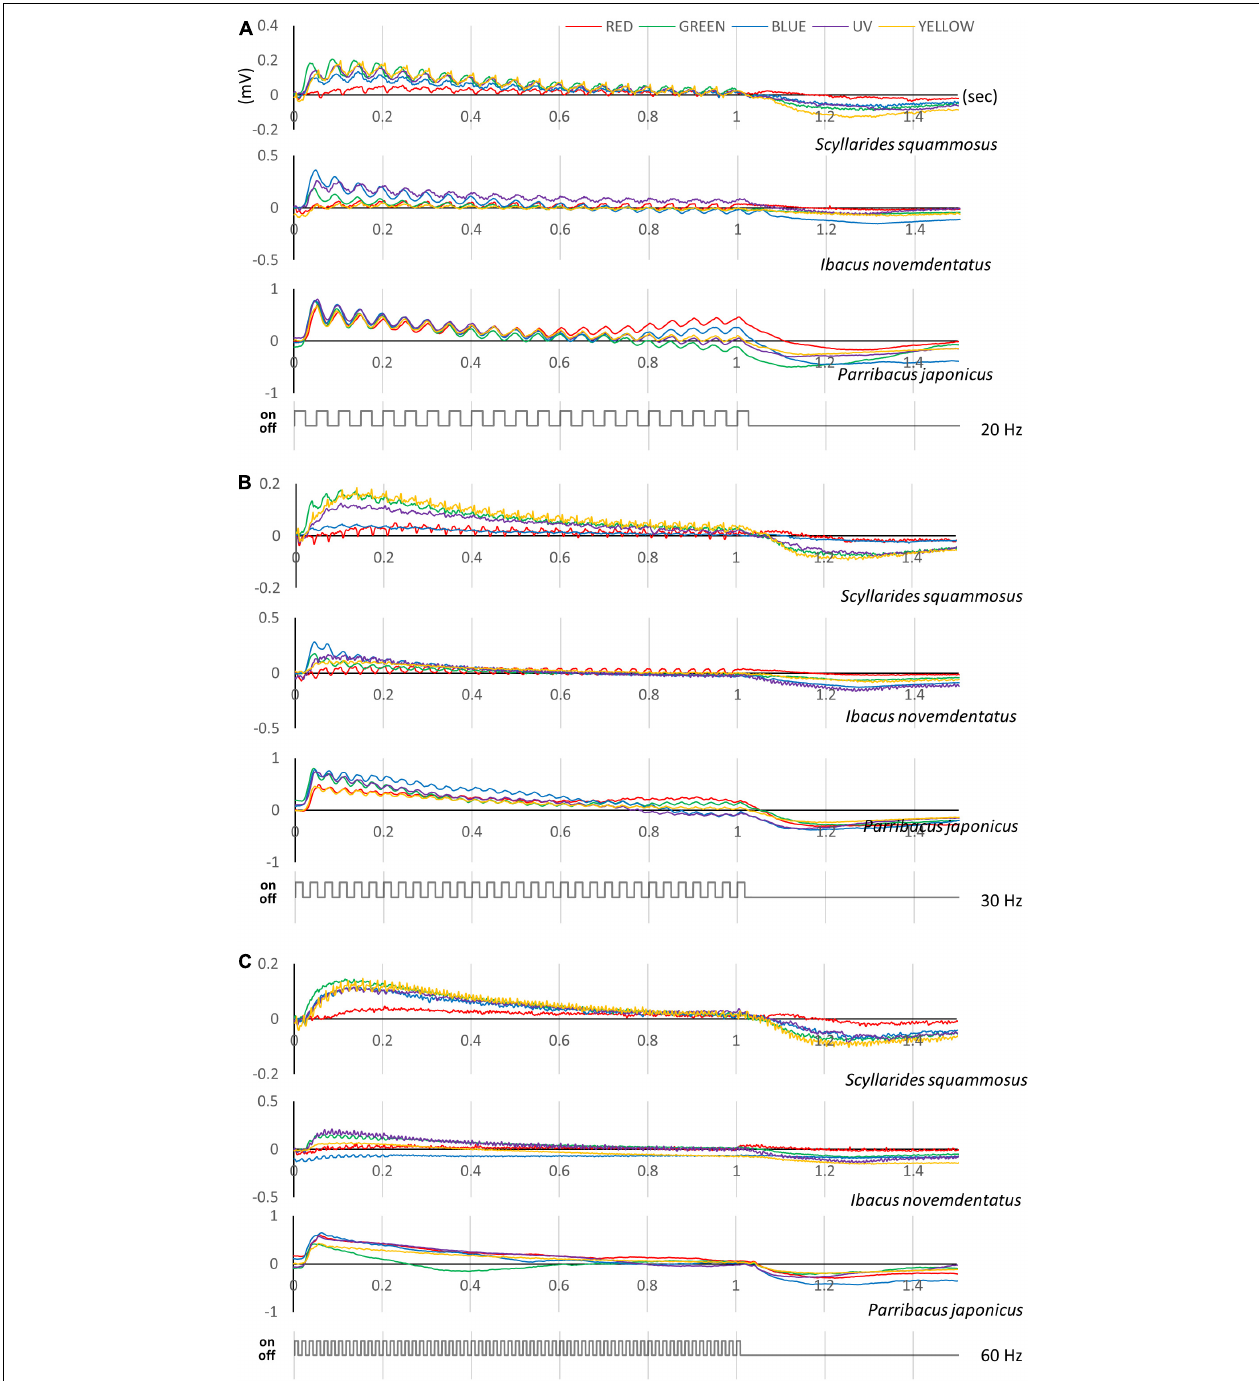
FIGURE 8 | Flicker ERG responses of slipper lobsters. Data for (A) S. squammosus , (B) I. novemdentatus , and (C) P. japonicas are shown. Typical flicker ERG traces taken from appropriate light stimuli for each spectrum at 20, 40, and 60 Hz. The color of each line represents the color of each spectrum. The intensities of the color stimuli were c. 10 - 1 –10 1 mol/m 2 /s for I. novemdentatus and c. 10 - 1 –10 2 mol/m 2 /s for S. squammosus and P. japonicas